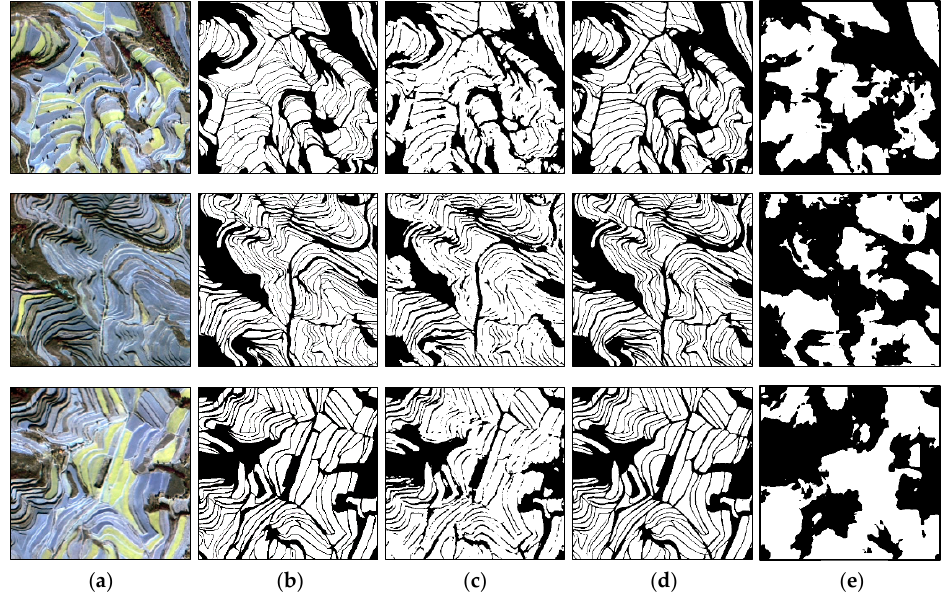
Figure 13. Comparison of terrace identification results in the test area. ( a ) Test images; ( b ) true labels; ( c ) direct training prediction images; ( d ) transfer learning strategy 2 prediction images; ( e ) transfer learning strategy 1 prediction images. The top, middle, and bottom rows are the prediction images for test areas 1, 2, and 3, respectively.